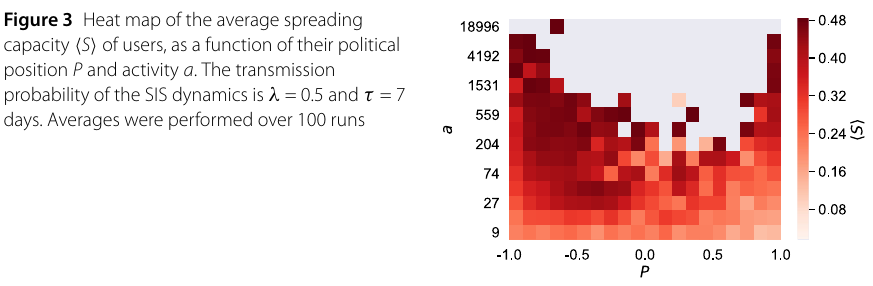
Figure 3 Heat map of the average spreading capacity (cid:2) S (cid:3) of users, as a function of their political position P and activity a . The transmission probability of the SIS dynamics is λ = 0.5 and τ = 7 days. Averages were performed over 100